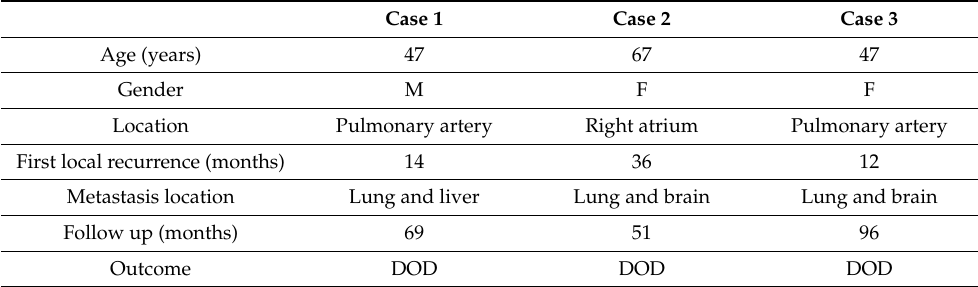
Table 1. Demographics and clinical data.